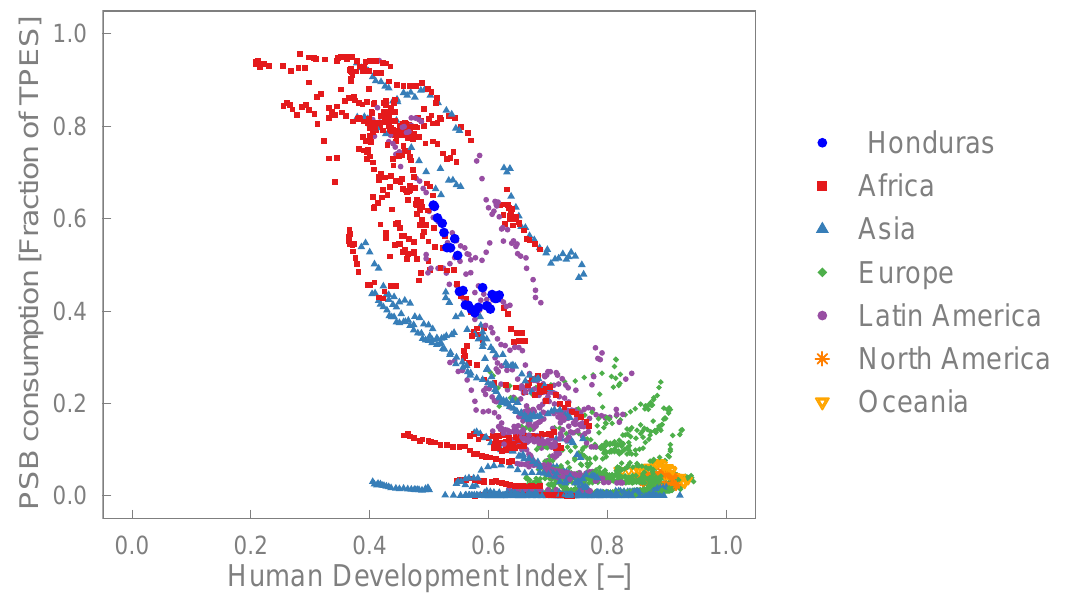
Figure 1. PSBs (as a fraction of the Total Primary Energy Supply, TPES) vs. Human Development Index (1990–2013) [4]. Countries generally move from top-left to bottom-right through